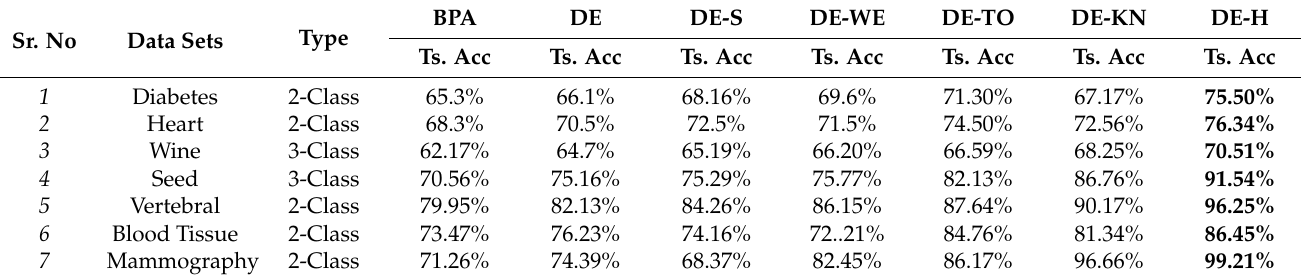
Results of 10-fold classification rates of ANN-training methods in for seven data sets for